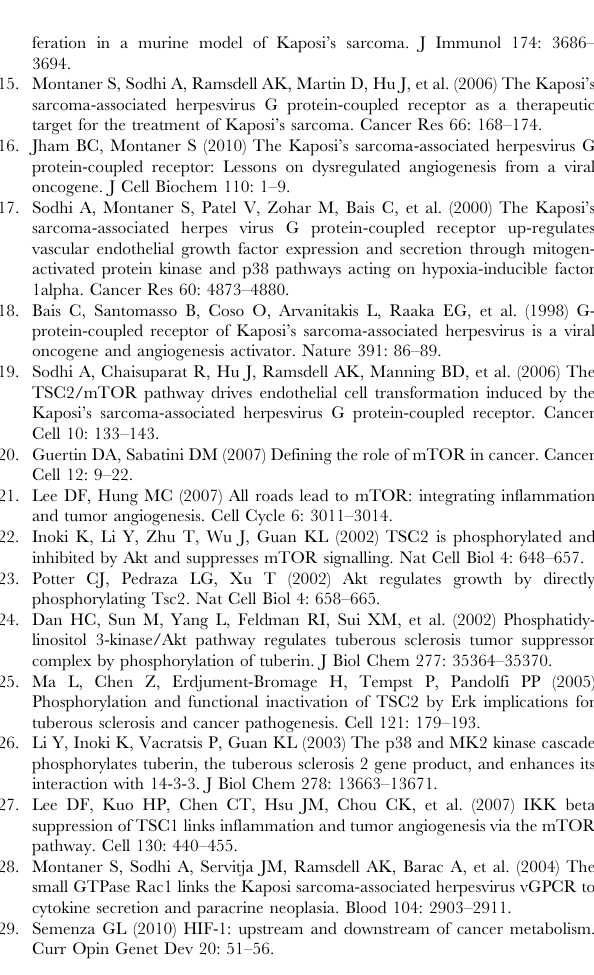
Figure S1 Specific vGPCR factors induce